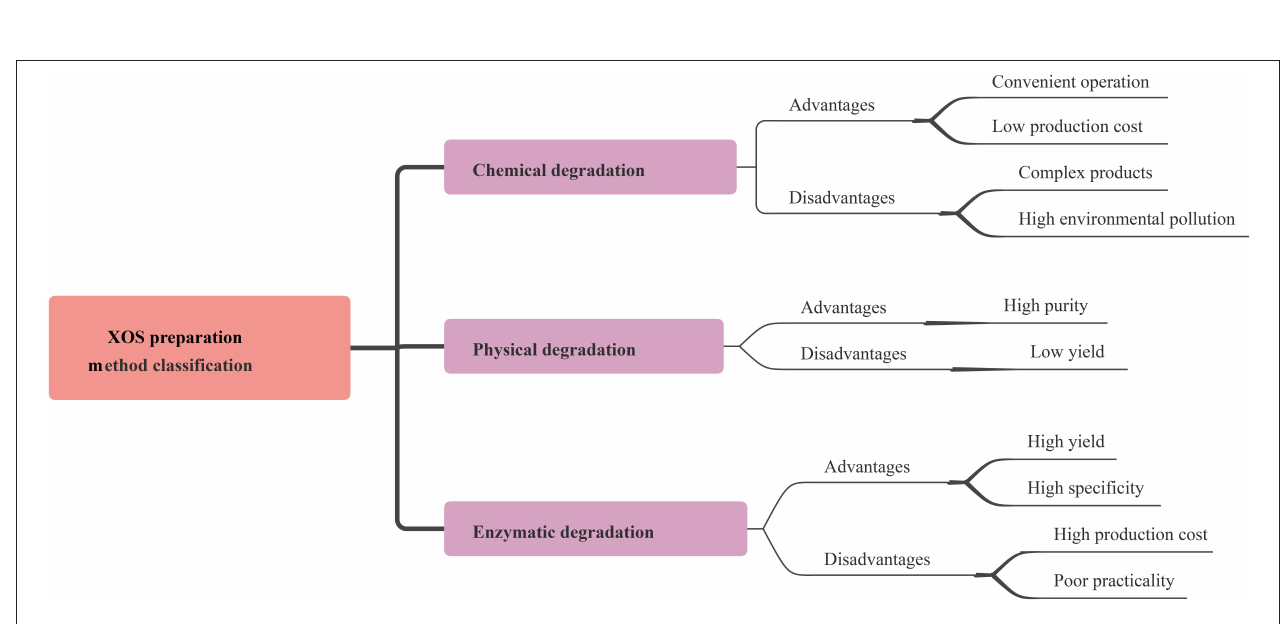
FIGURE 3 | Characterization of XOS preparation